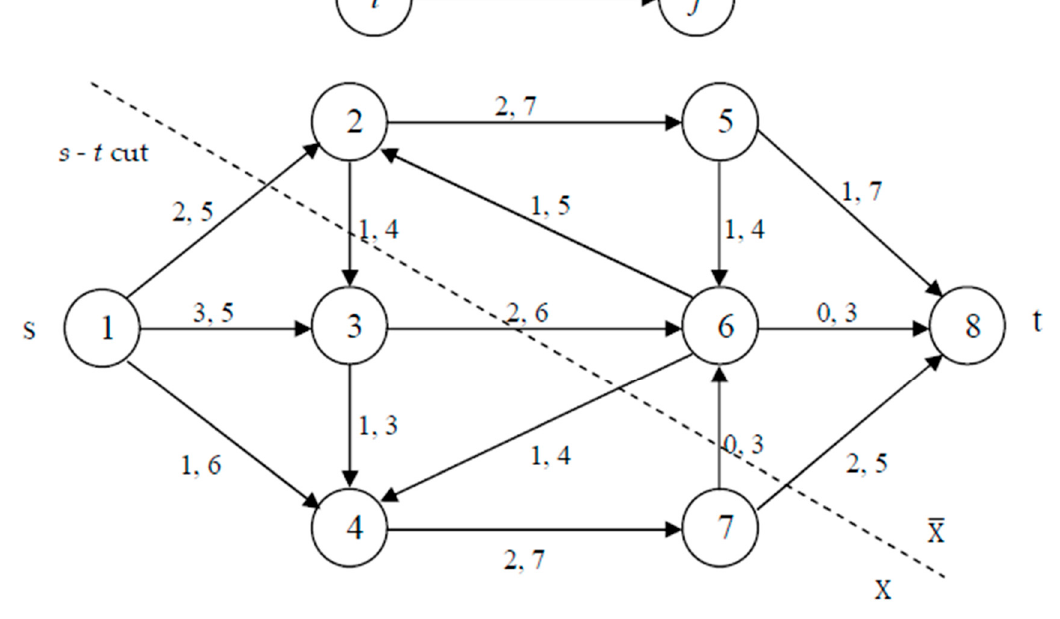
Figure 1. Initial network G and s-t cut [X,X ̅ ].